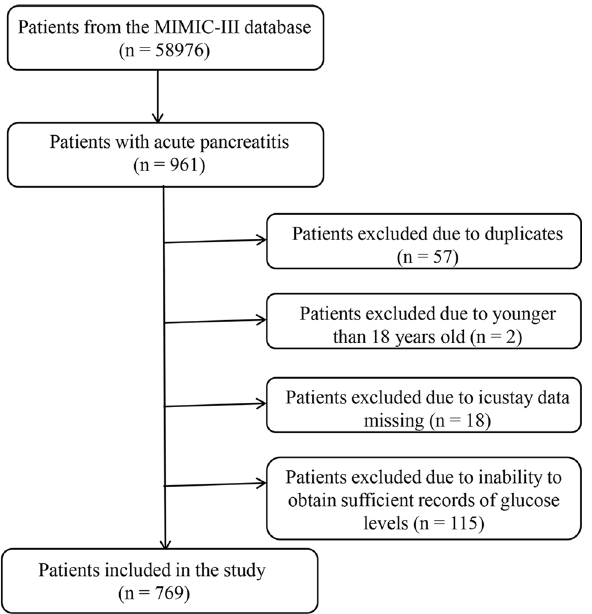
Figure 1. Flow chart of the study selection